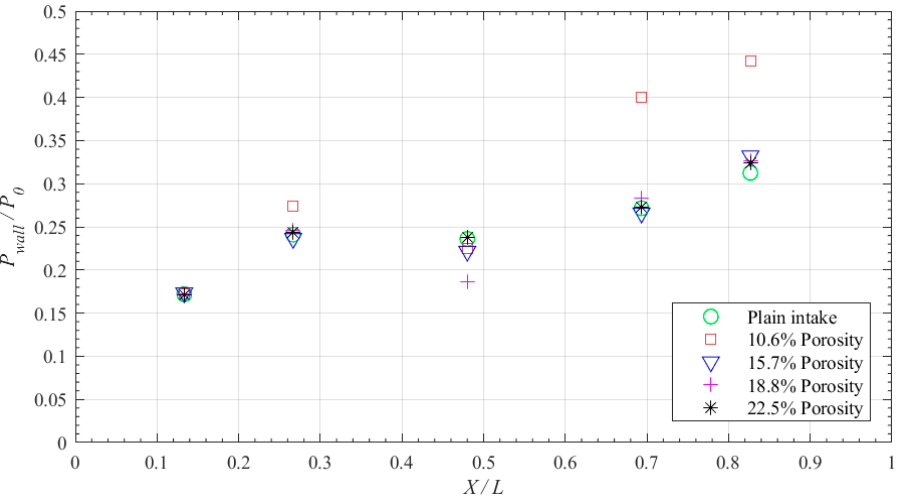
Figure 14. Static pressure variation along the intake-core due to wall ventilation at R c = 1.22.